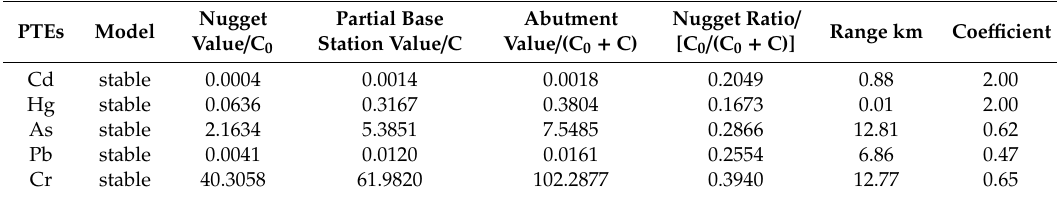
Table 5. The fitting model and parameters of spatial variation semivariogram of